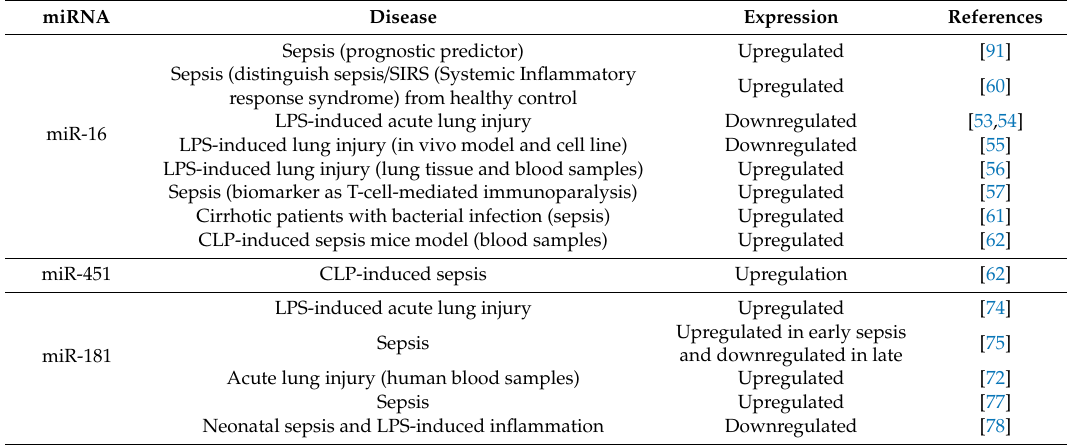
Table 2. Evidence of the miRNA expression profile in a sepsis population with or without lung injury. miRNA